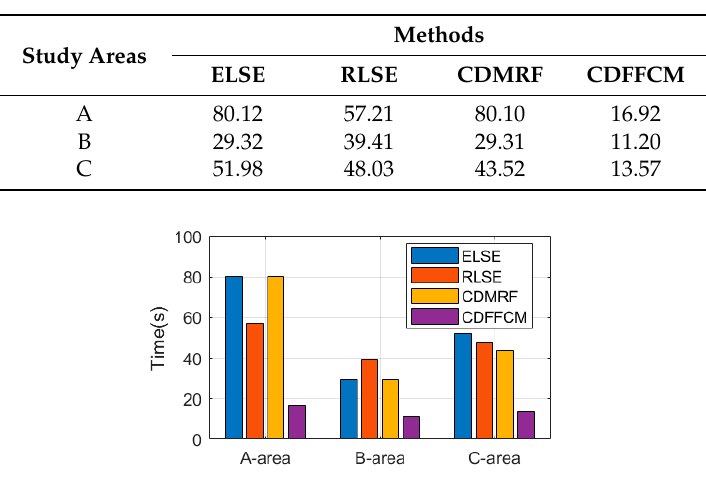
Figure 19. Bar-chart corresponding to the values in Table 6.